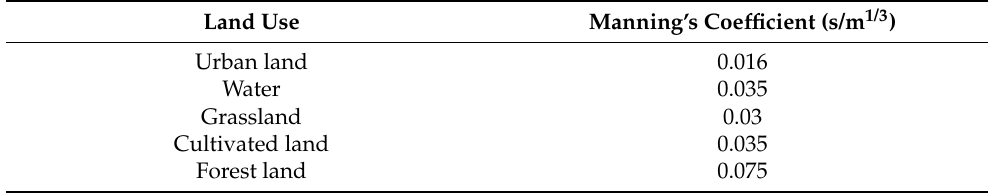
Table 2. Manning’s coefficient.